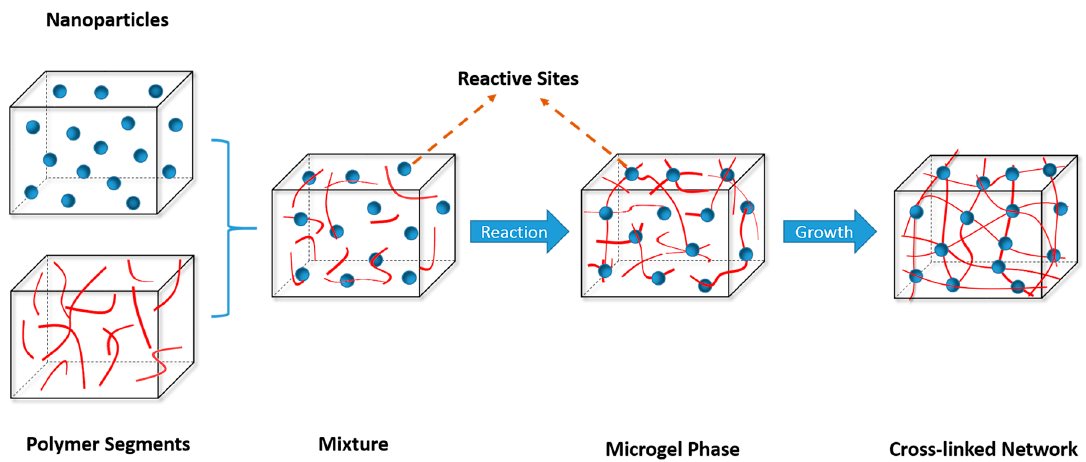
Figure 2. Schematic diagram of the bisphenol A dicyanate (BADCy) resin nanoparticles initiating matrix curing.